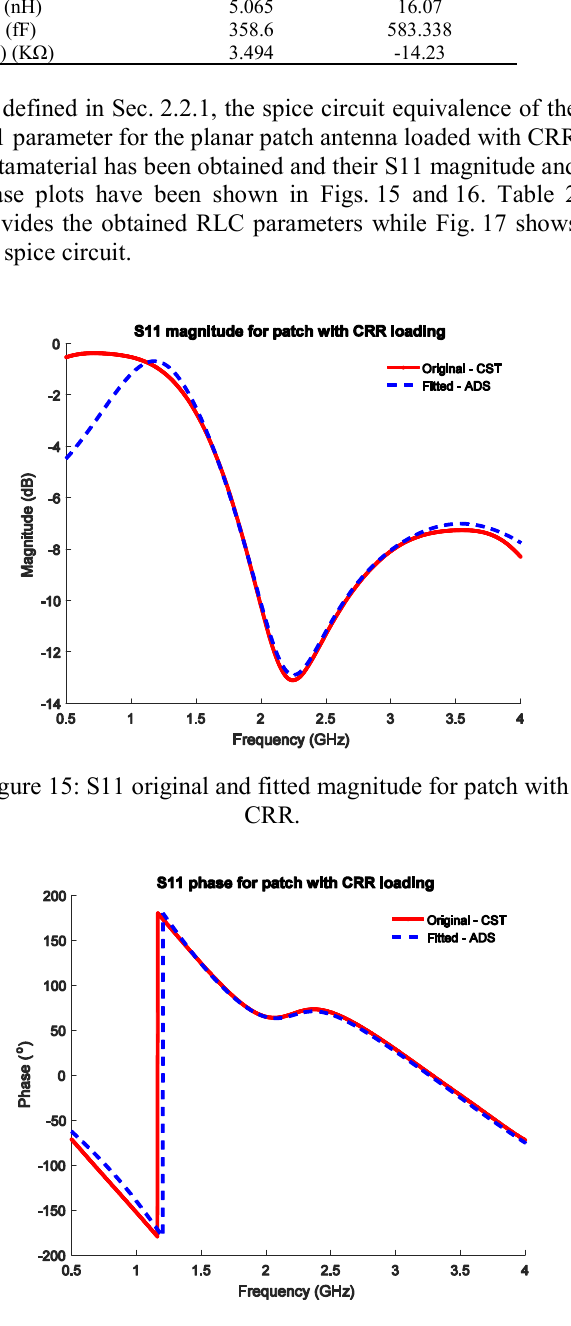
Figure 16: S11 original and fitted phase for patch with CRR.